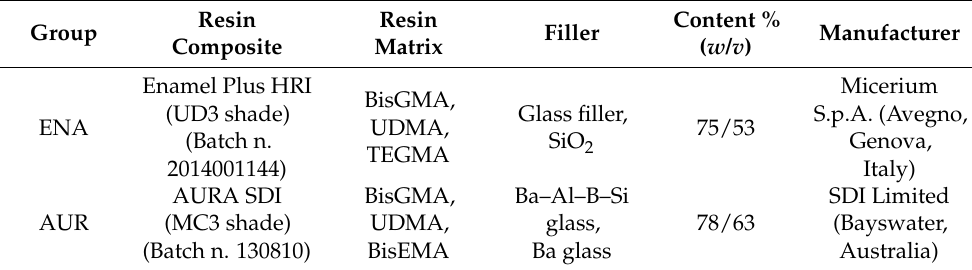
Table 1. Summary of the materials used in experimental